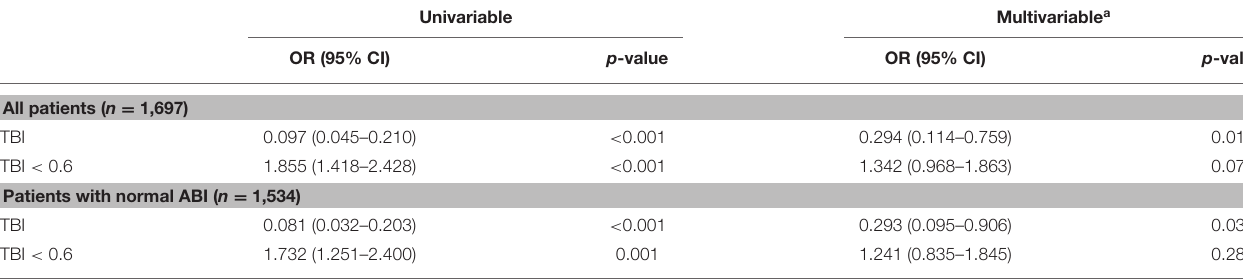
TABLE 2 | Logistic regression analysis of TBI for poor functional outcomes at 3 months. Univariable Multivariable a OR (95% CI) p -value OR (95% CI) p